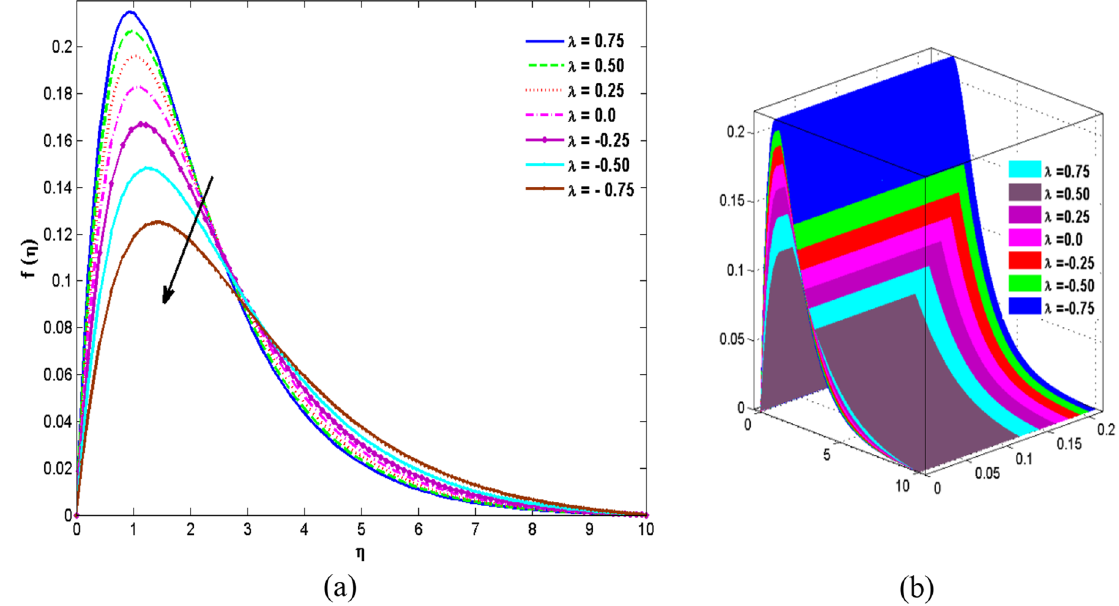
Figure 3. Variations of (cid:31) to f (η) .